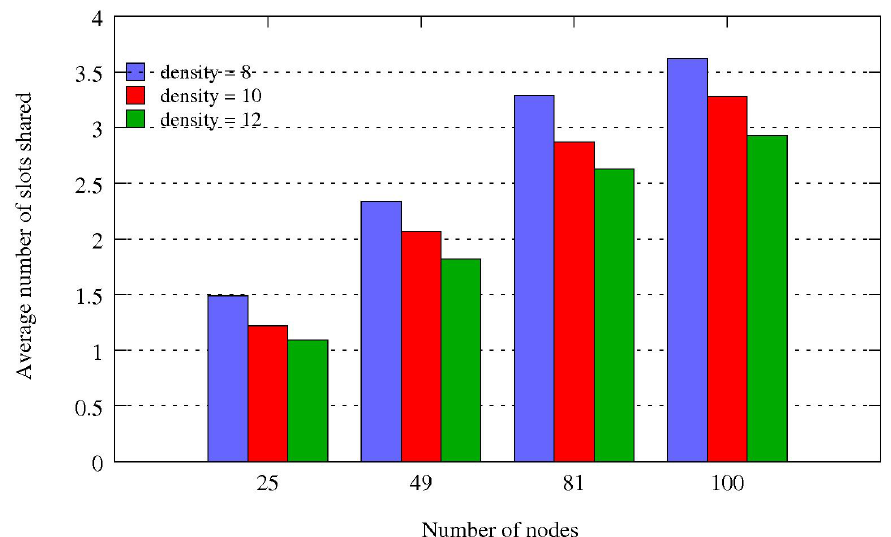
Figure 12. Average number of nodes sharing the same